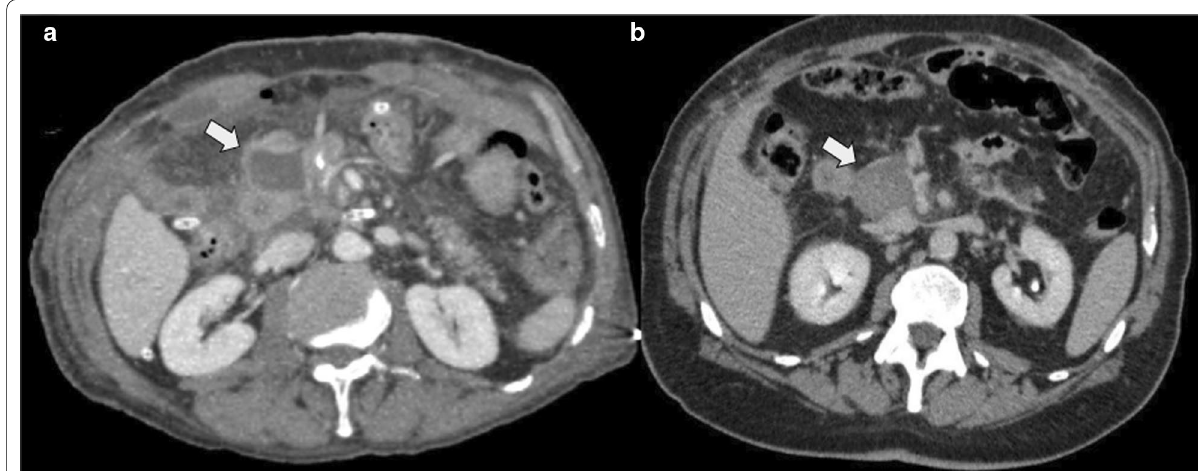
Fig. 20 Biliary vs pancreatic fistula. Two different patients ( a ) 65-year-old male patient during abdominal pain three weeks after pancreaticoduodenectomy due to adenocarcinoma. ( b ) 50-year-old male patient with fever 21 days after pancreaticoduodenectomy due to ampulloma. Both patients presented fluid collection near the surgical bed, the both were homogeneous and no enhancement was present (big arrows). Fluid drainage analysis confirmed biliary fistula in a and pancreatic fistula in b . Note the similar imaging appearance, being indistinguishable one fistula from each other